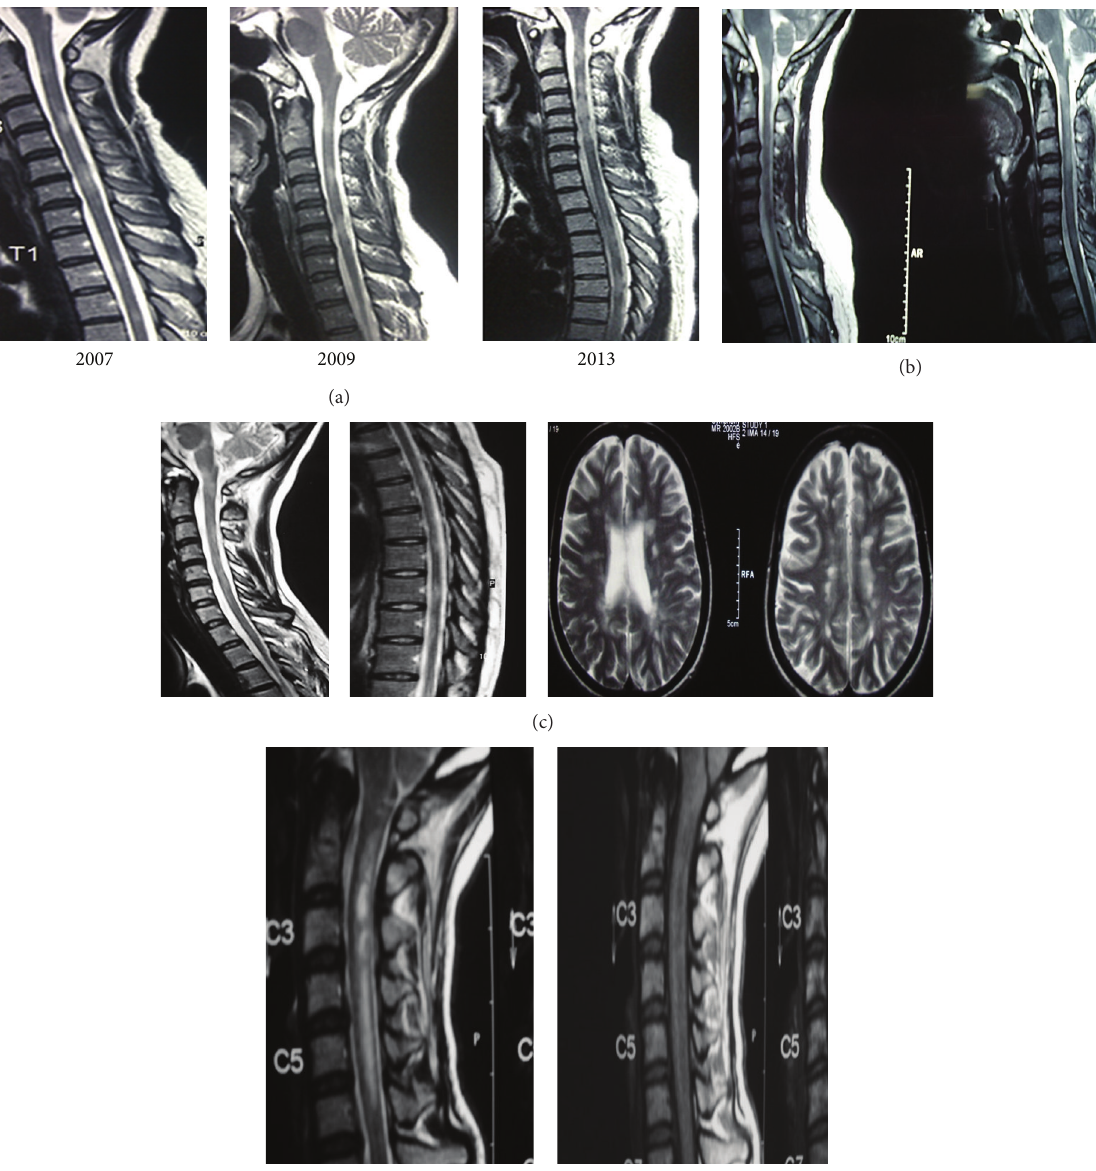
Figure 1: (a) Sagittal T2WI of the spine showing coalescing of multiple short segment lesions in a patient with relapsing-remitting multiple sclerosis at onset of disease and on follow-up once she entered the progressive phase of disease. (b) Sagittal T2WI of the spine showing a relapsing-remitting patient with multiple sclerosis with a short segment lesion superimposed on a longer patchy lesion at onset of disease. (c) Sagittal T2WI of the spine showing patchy ill-defined lesions more than 3 vertebral segments involving the entire cervicothoracic cord and axial T2WI of MRI brain with clinically definite multiple sclerosis in a patient with secondary progressive disease. (d) Sagittal T2WI (left) of the cervical spine showing a longitudinally extensive cord lesion with edema and corresponding T1WI (right) with T1 hypointensity within the cervical cord in a patient with neuromyelitis